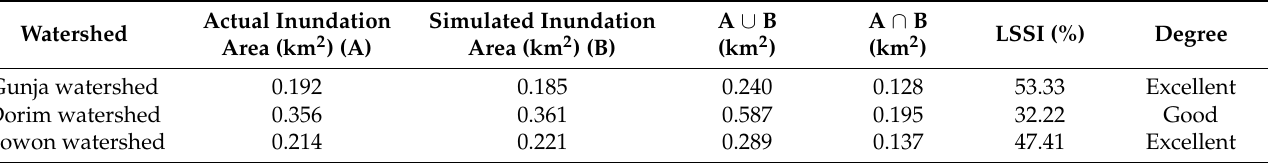
Figure 9. Comparison of inundation trace and simulated flood range in the ( a ) Gunja, ( b ) Dorim, and ( c ) Dowon watersheds. Table 3. Comparison of the actual inundation area with the simulated